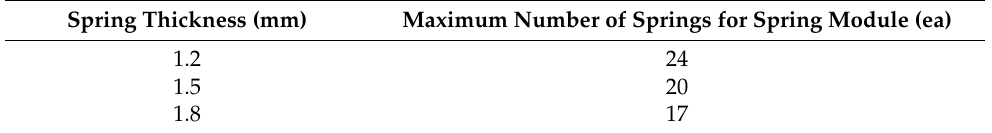
Figure 8. Height of the spring module limited by the geometry of the engine part. Table 2. Maximum number of springs for the spring module according to spring thickness.